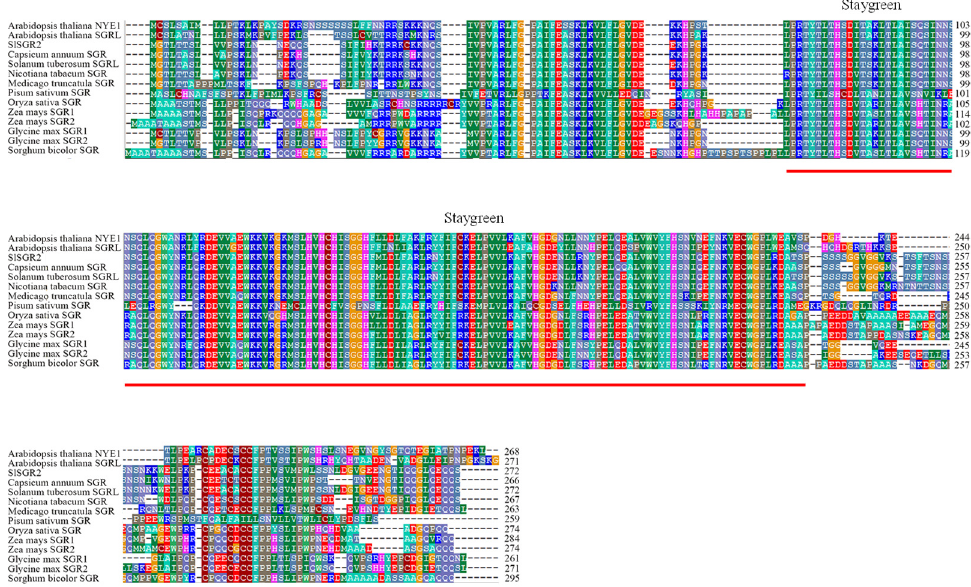
Figure 3. Homologous multiple alignment of amino acid sequences.